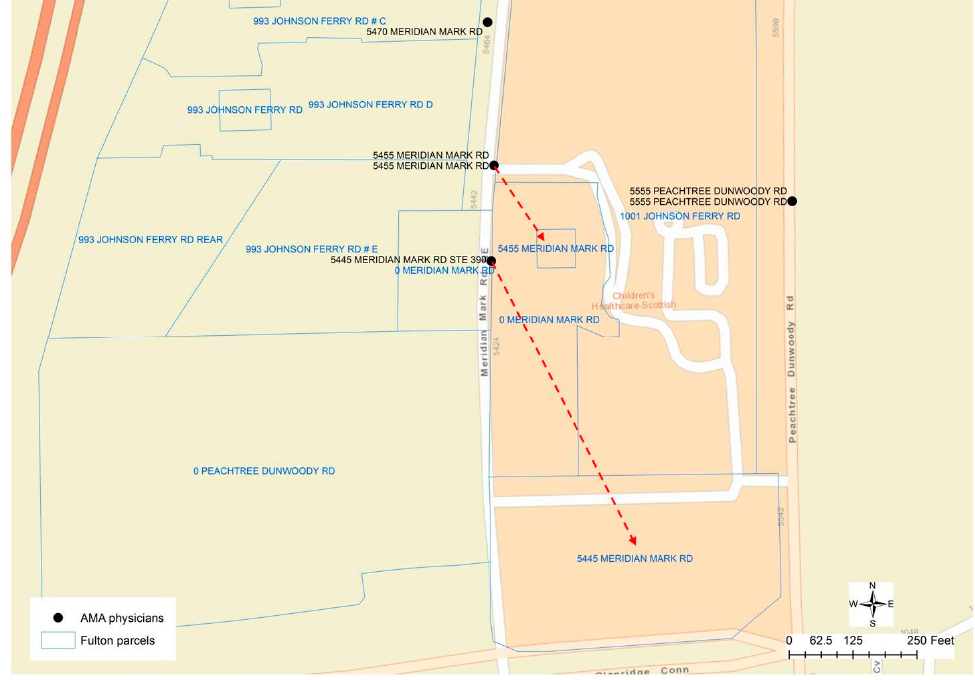
Figure 3. Physicians’ location vs. parcels that have the same address.